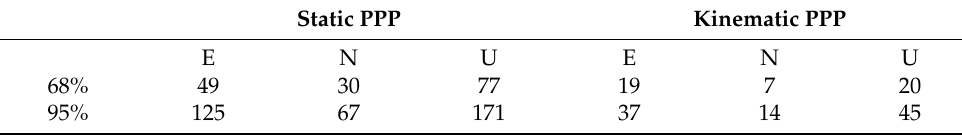
Table 17. Convergence time of the EG method (unit: min) (G/R/B/E). Static PPP